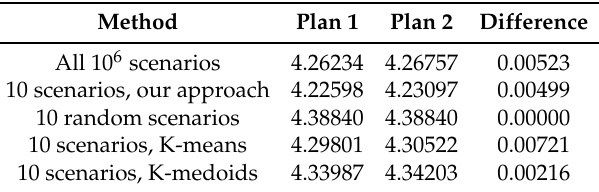
Table 6. Average social welfare (in $10 15 ) for the two transmission plans estimated using different